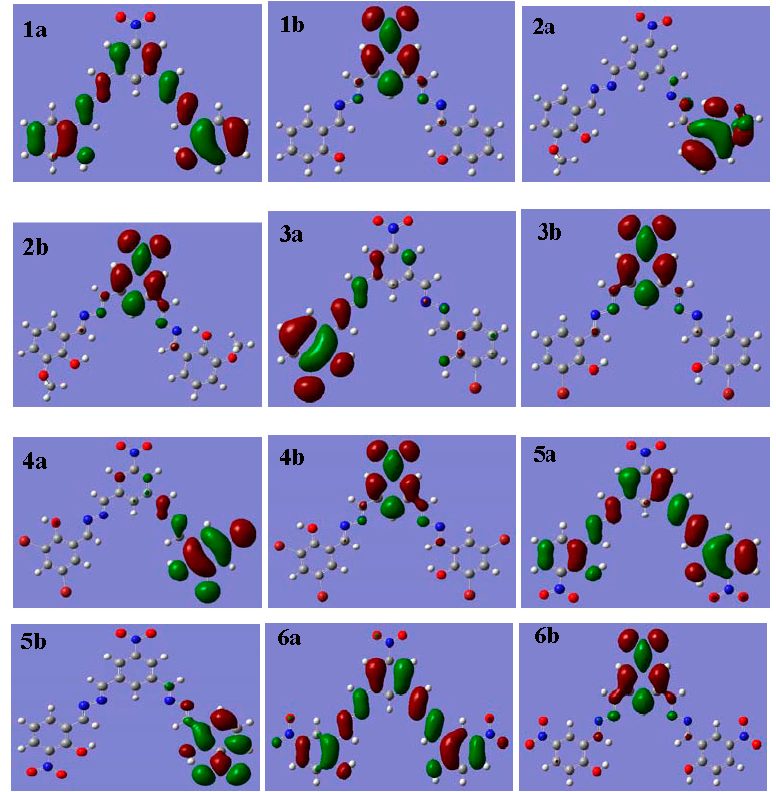
Figure 7. Selected HOMO ( a ) and LUMO ( b ) distributions of 1 – 6 . ( 1a,b ) Compound 1 ; ( 2a,b ) Compound 2 ; ( 3a,b ) Compound 3 ; ( 4a,b ) Compound 4 ; ( 5a,b ) Compound 5 ; ( 6a,b ) Compound 6.